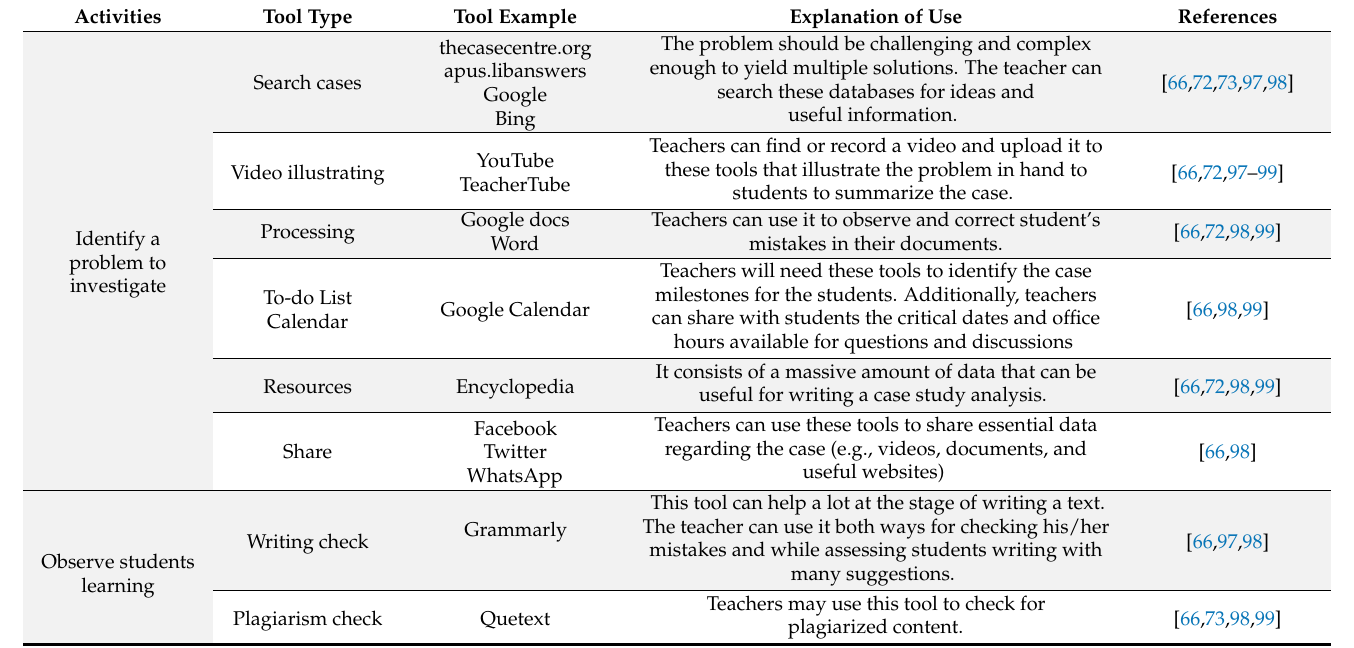
Table 6. PTE guide for case